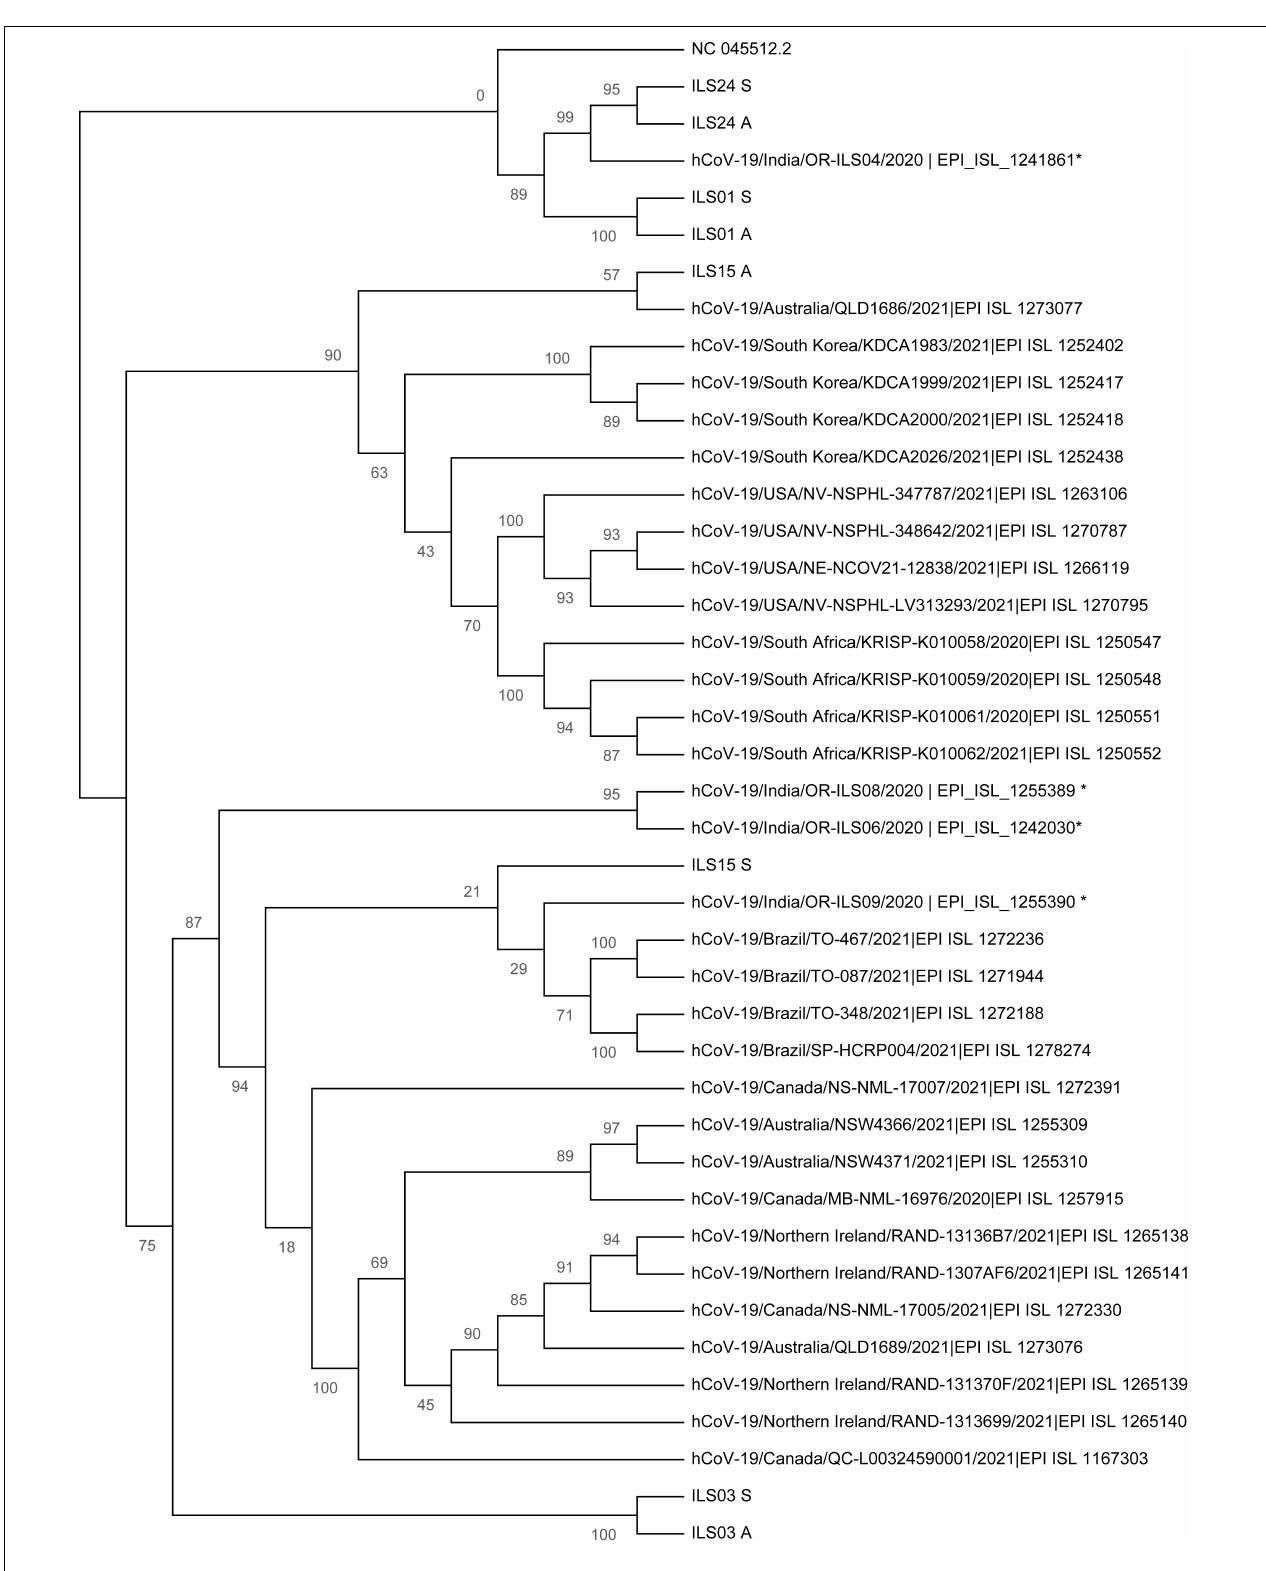
FIGURE 7 | Phylogenetic network analysis of the isolated viruses: Maximum likelihood (ML) tree of studied viral sequences in combination with 33 SARS-CoV-2 genome sequences representing different countries around the globe including four sequences from Odisha, India. Bootstrap (n = 1,000) values are represented as branch